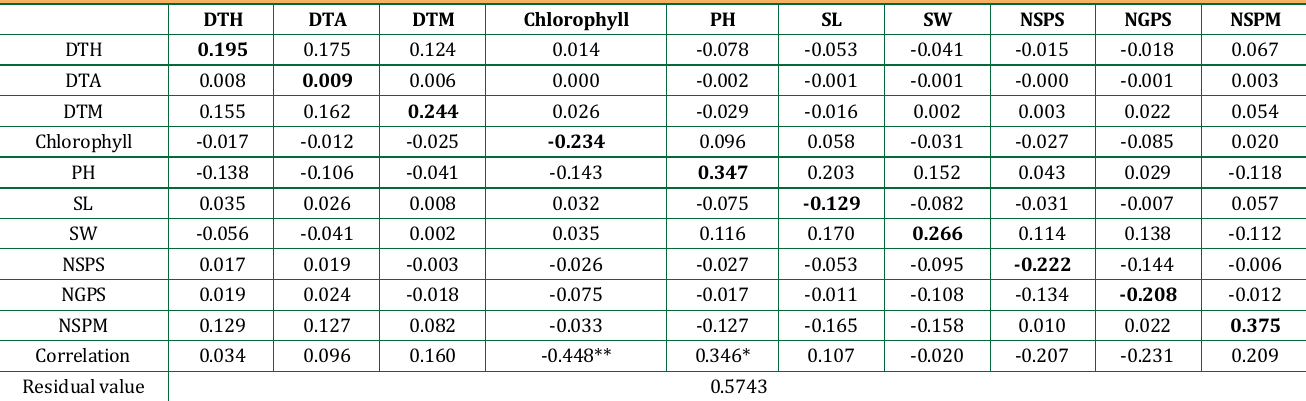
Table 5: Path analysis between grain yield and other characters at the phenotypic